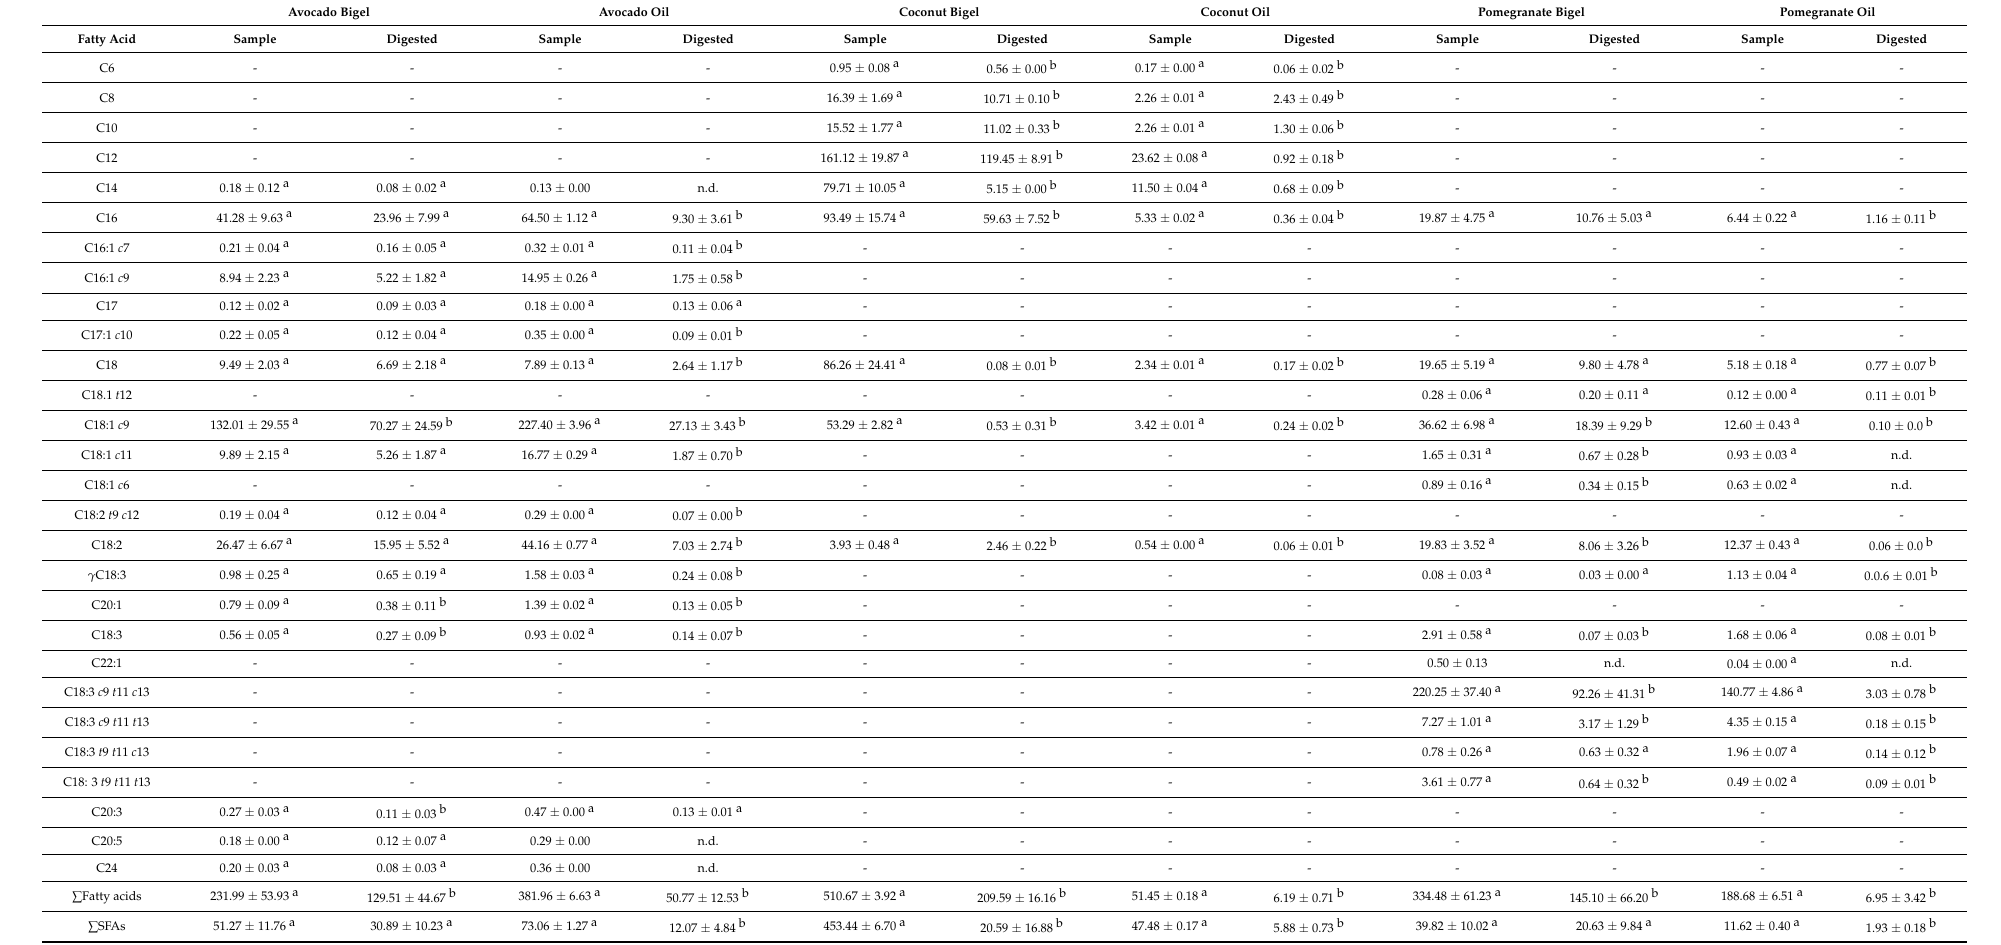
Table 2. Fatty acids profile of bigel and plain vegetable oil samples upon digestion via in vitro simulated gastrointestinal tract. AvocadoBigel AvocadoOil CoconutBigel CoconutOil PomegranateBigel